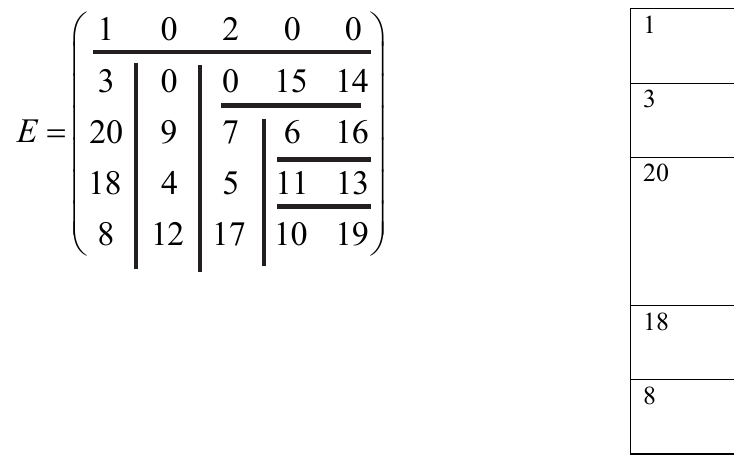
Fig. 1. Location matrix, slicing structure and the corresponding